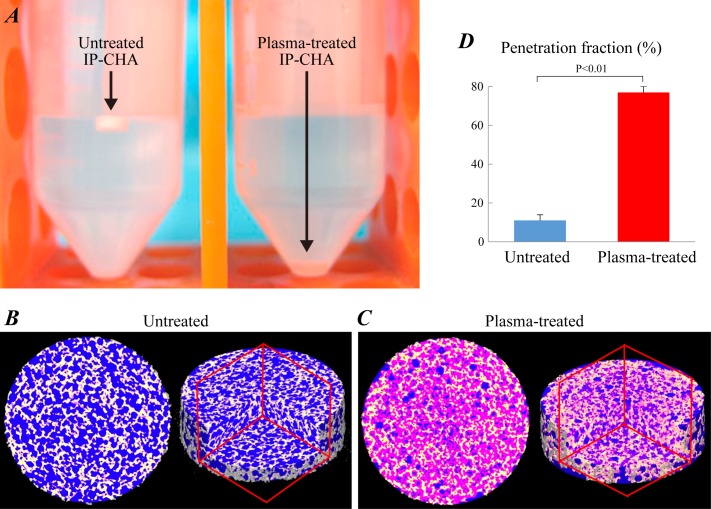
Analysis of water penetration into IP-CHA.(A) Photographs of untreated and plasma-treated IP-CHA discs (φ5 mm × h2 mm) soaked in the deionized water containing 6% contrast medium (CM, Oypalomin™). Both discs were soaked in the CM solution for 10 minutes, and evaluated by μCT regarding penetration of CM solution into inner pores. The μCT cross section at half height (left) and 3D (right) images of untreated (B) and plasma-treated IP-CHA discs (C). Each image is composed of three parts: yellow for HA, blue for empty space (i.e. unfilled pores) and pink for the CM solution (i.e. CM filled pores). (D) Penetration fraction of inner pores was calculated. Data were expressed as mean ± SD.